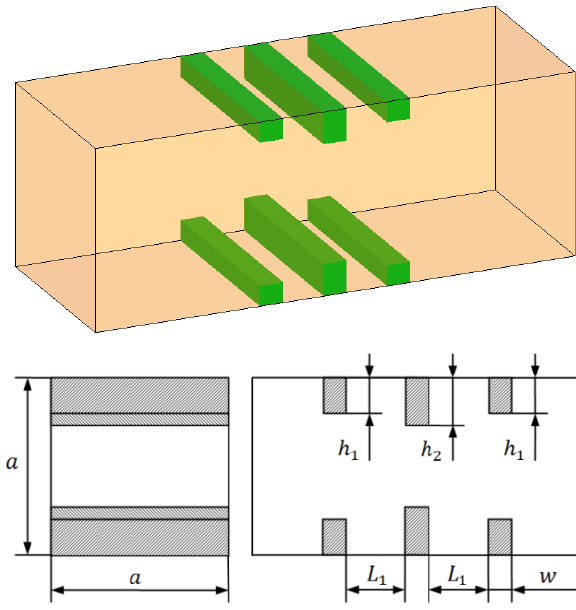
FIGURE 1. Structure of a square waveguide polarizer with three